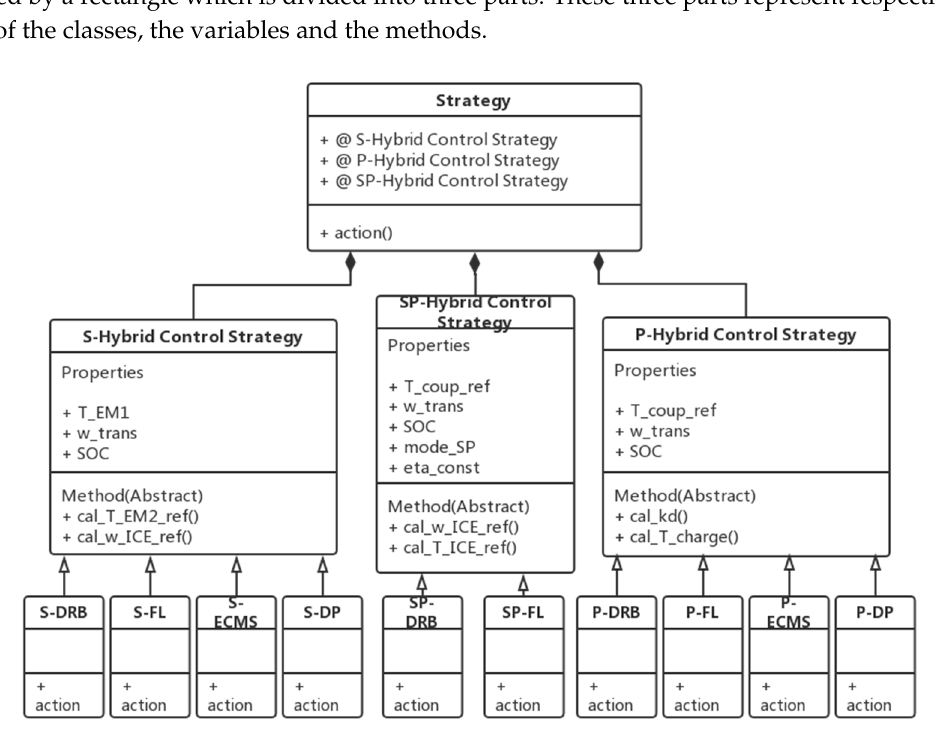
( c ) Figure 8. UML of environment, ICE and battery OOP model: ( a ) UML of ENV; ( b ) UML of ICE; and ( c ) UML of BAT. The vehicle class is a base-class that contains three sub-classes which are transmission, wheel and chassis. Vehicle parameters need to be set for the transmission ratio, transmission efficiency (e_GT) and HEV quality related parameter (K_chas) as well as the PID controller parameters (PID_controller), which is shown in Figure 9.